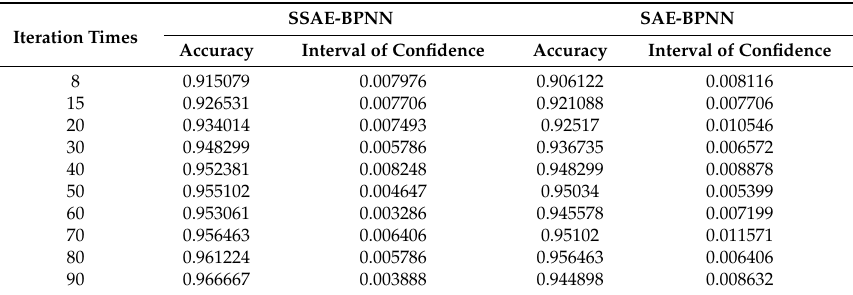
Table 3. Accuracy and interval of confidence of SSAE-BPNN & SAE-BPNN.